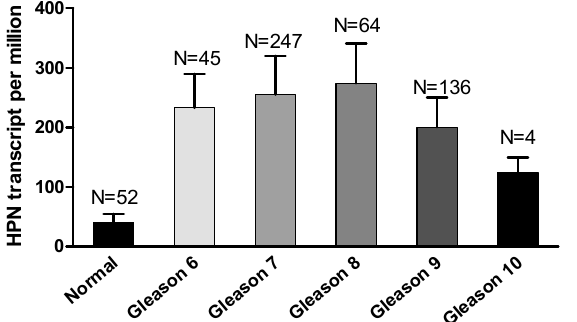
Figure 3. Hepsin expression levels were not associated with Gleason scores in prostate cancer. To determine the roles of hepsin in prostate cancer prognosis, the TCGA prostate cancer survival data (550 cases) were analyzed, showing that higher expression of hepsin was slightly associated with a shorter survival time, including overall survival, disease- specific survival, disease-free survival, and progression-free survival. (Figure 4). Similar results were observed for ovarian cancer, breast cancer, and gastric cancer upon analyzing 1435 cases of ovarian cancer (401 cases of low and 1034 cases of high expression), 1089 cases of breast cancer (279 cases of low and 810 cases of high expression), and 875 cases of gastric cancer (517 cases of low and 358 cases of high expression, respectively (Supplementary Figure S3A–C). By contrast, the higher expression of hepsin was positively associated with renal and hepatocellular carcinoma survival according to the analysis of 530 cases of renal cancer (131 cases of low and 399 cases of high expression) and 370 cases of liver hepatocellular carcinoma (136 cases of low and 234 cases of high expression) (Supplementary Figure S3D,E).